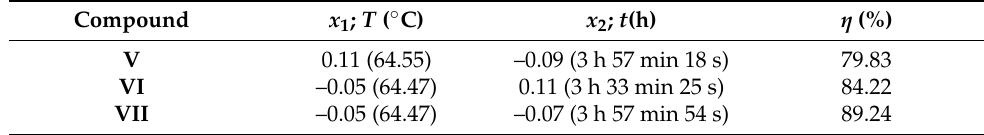
Table 4. The most favorable conditions for obtaining the compounds V – VII .